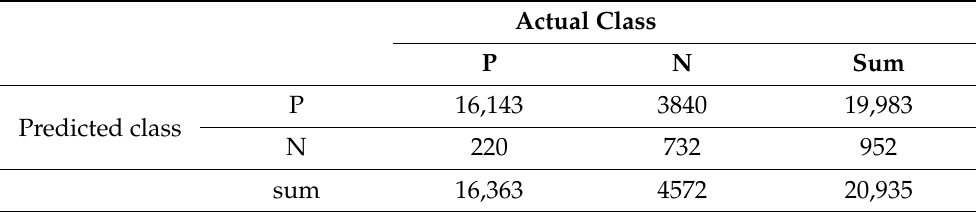
Table 2. Confusion matrix of SVM of scikit-learn.